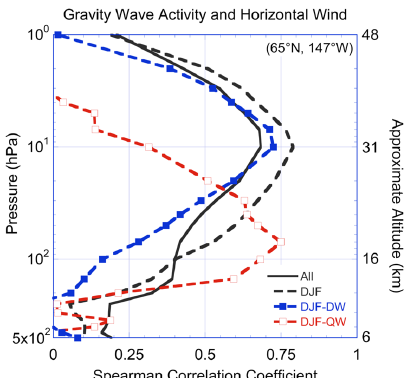
Figure 13. Spearman correlations of gravity wave-specific potential energy and horizontal wind speed in altitude at Chatanika. “All“ represents all 152 nights. “DJF” represents all winter nights (December, January, February). “DJF-DW” represents all winter nights in disturbed winters. “DJF-QW” is all winter nights in quiet winters.